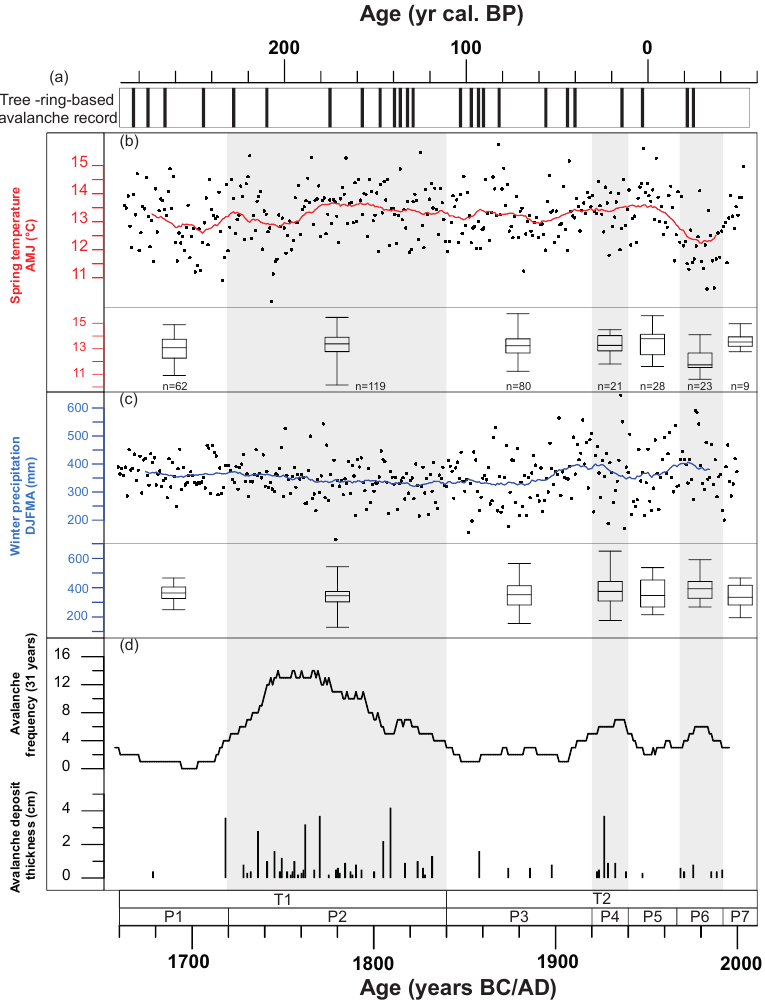
Figure 8. Comparison between Lake Lauvitel avalanche record and climate parameters over the last 350 years. (a) Tree-ring-based avalanche record from Corona et al. (2013); (b) spring temperature (AMJ) record (on a 31-year average in red) and (c) winter precipitation (DJFMA) (mm) (on a 31-year average in blue) based on instrumental and documentary proxy data on a monthly basis from Casty et al. (2005). Data are summarized in box-and-whisker plots corresponding to each identified period (P1 to P7). (d) Lake Lauvitel avalanche frequency and avalanche deposit thickness. Grey bands indicate the period of higher avalanche